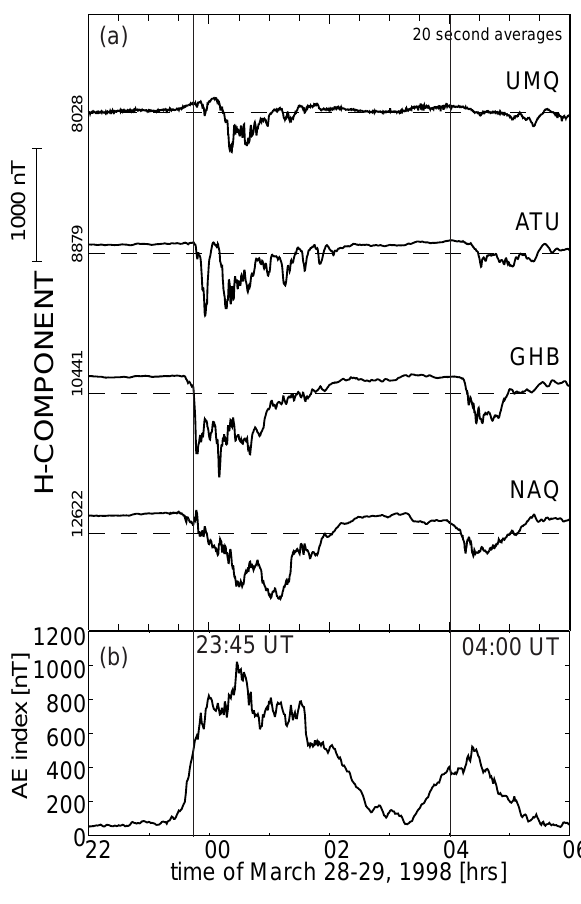
Fig. 2. (a) Ground magnetic field H component of the magnetome- ter stations UMQ (northernmost in this plot), ATU, GHB, and NAQ (southernmost) on the west coast of Greenland . (b)